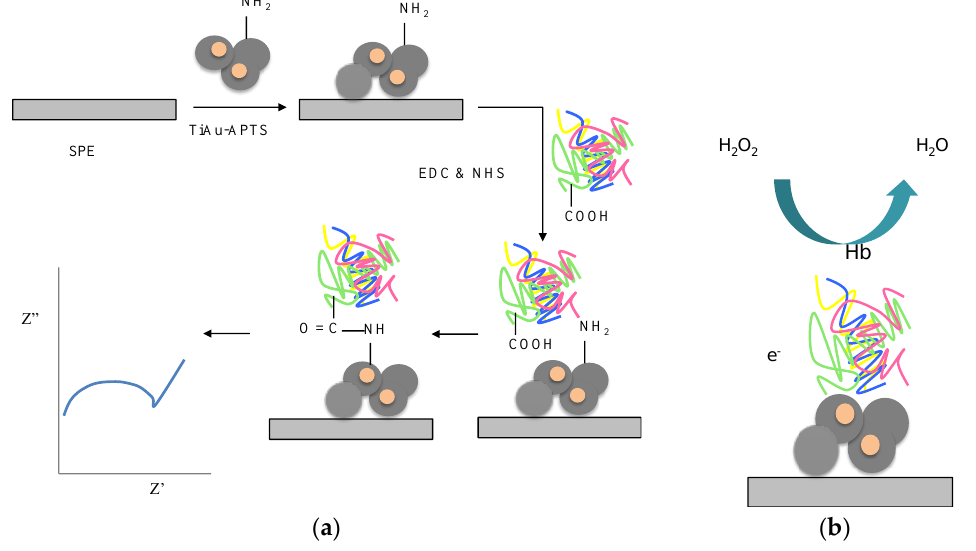
Figure 1. ( a ) Fabrication steps and ( b ) mechanism of the Hb/TiAu-APTS/SPE impedance biosensor using the EDC-NHS route for Hb immobilization on the modified electrode.